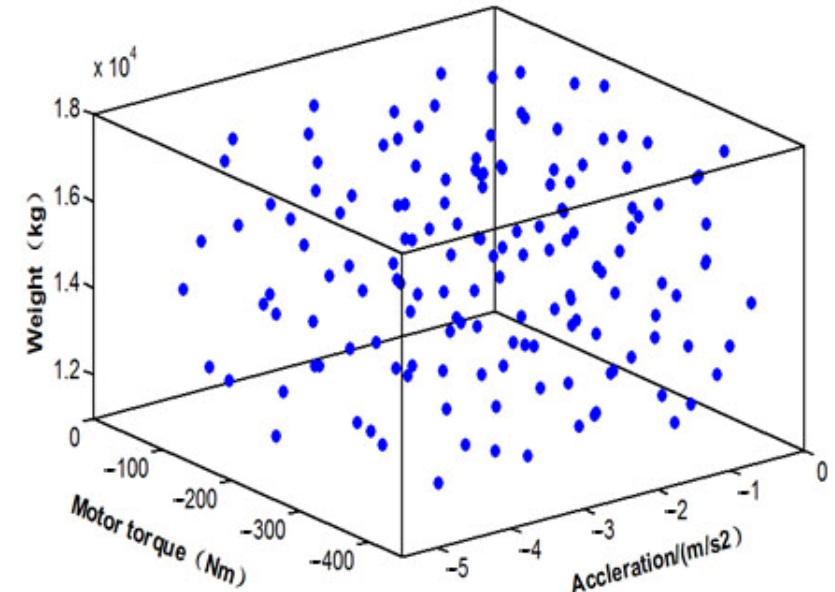
Figure 8. Latin hypercube sampling points.